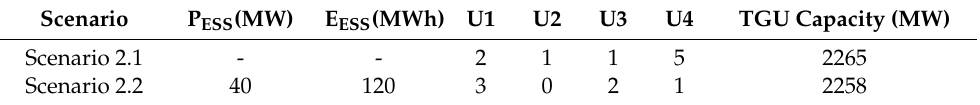
Table 6. Optimal schemes on the effect of an